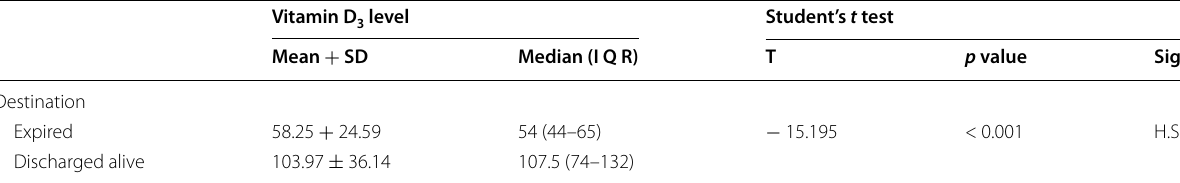
level and destination 3